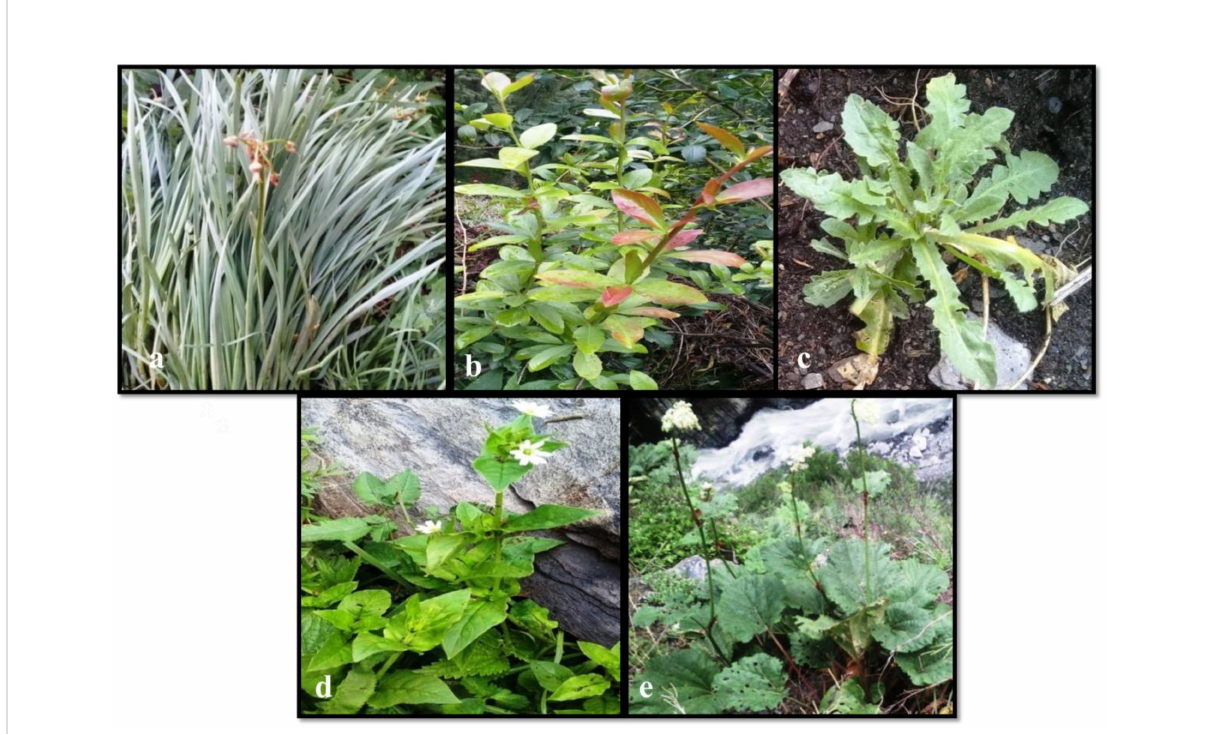
FIGURE 1 Wild edible plants used by Gaddis: (A) Allium rubellum, (B) Berberis chitria, (C) Capsella bursa-pastoris, (D) Stellaria aquatica, and (E) Rheum